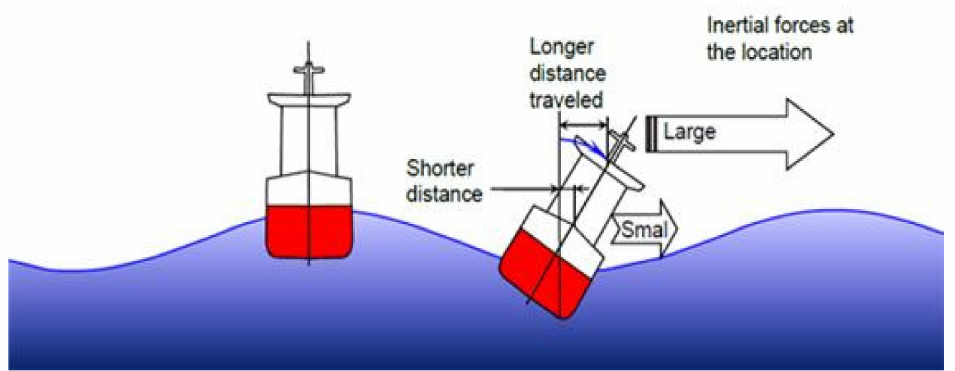
Figure 1. Scenario of stability failure related to excessive acceleration mode